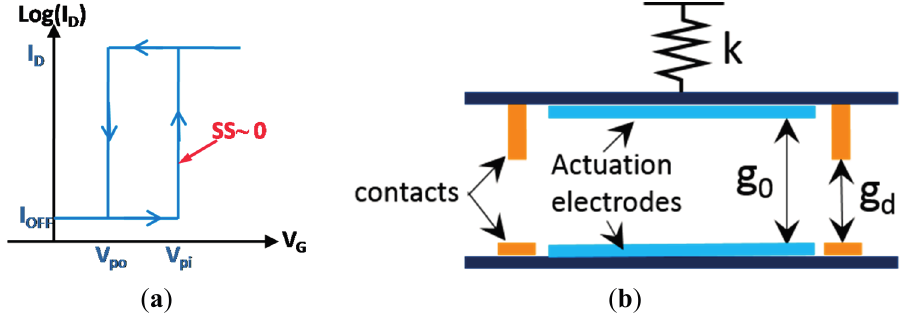
Figure 4. ( a ) Electrical characteristics of a nano-electro-mechanical (NEM) relay. ( b ) Spring model of a NEM